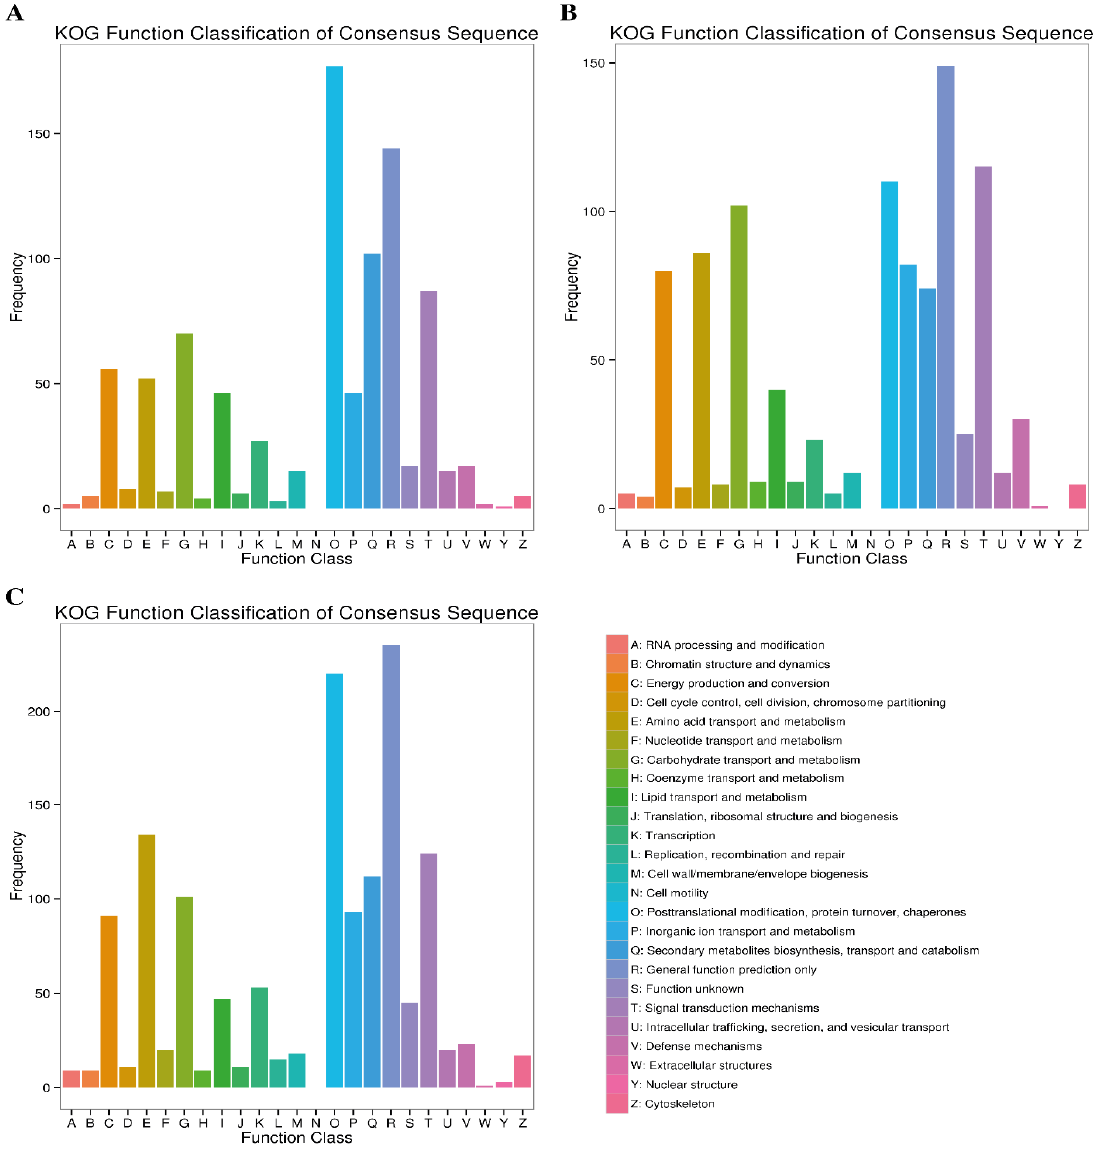
Figure 7. KOG pathway annotation of DEGs at three comparative stages under Cd stress. ( A ) At 7d of Cd stress; ( B ) at 14d of Cd stress and ( C ) at 30d of Cd stress.